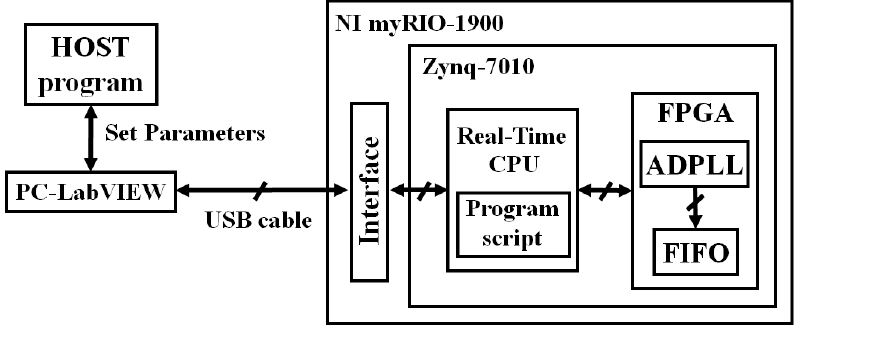
Figure 7. Block diagram of the experiment setup.